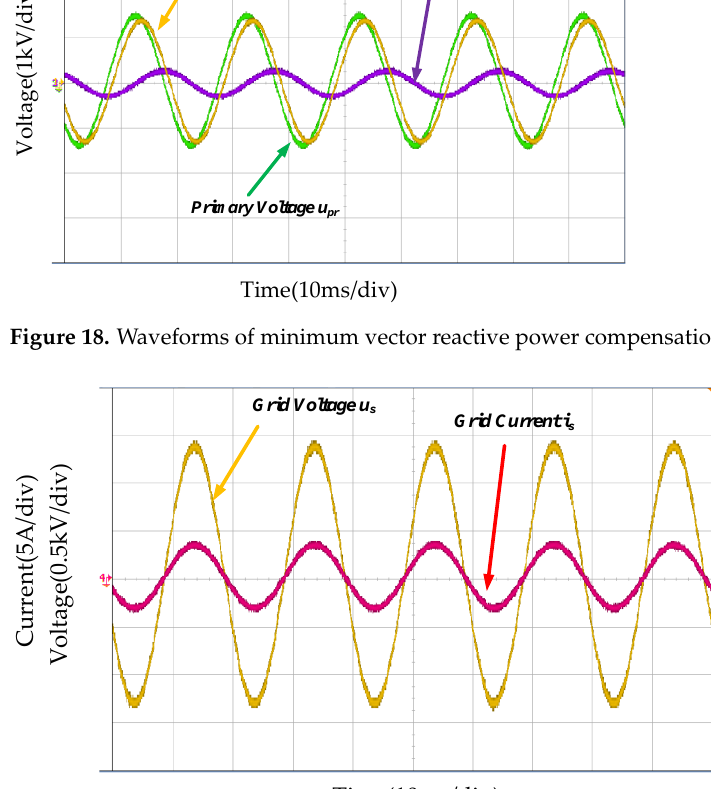
Figure 19. Waveforms of unit power factor operation with flexible OLVR.